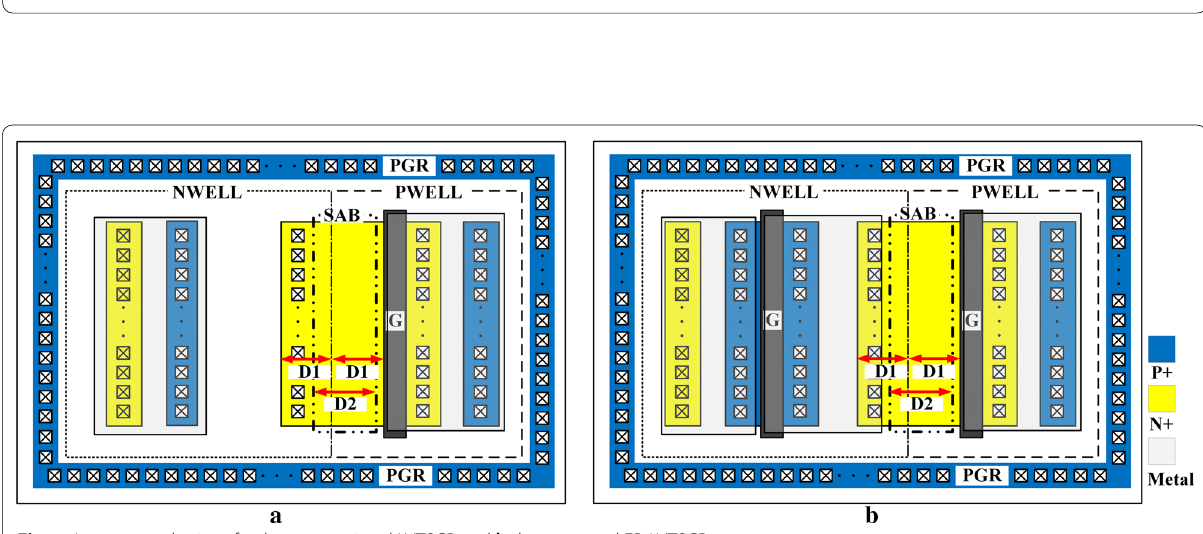
Fig. 3 TCAD-simulated electrostatic potential distributions of a the proposed EP-LVTSCR and b the conventional LVTSCR at t 1.2A-TLP stress